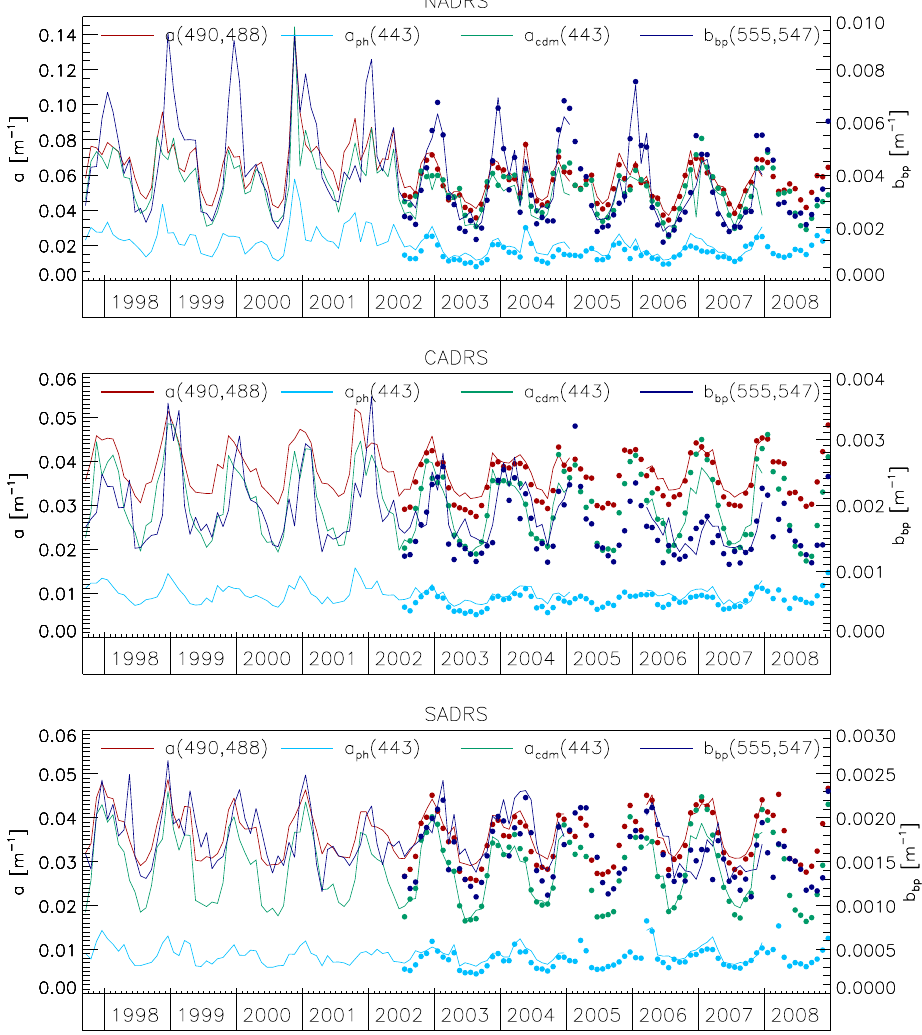
Fig. 2. Monthly time series averaged over the sub-basins NADRS, CADRS, and SADRS for SeaWiFS/MODIS a S (490), a A (488), a ph (443), a cdm (443), b S (555) and b A (547). SeaWiFS and MODIS values are represented by lines and circles, bp bp